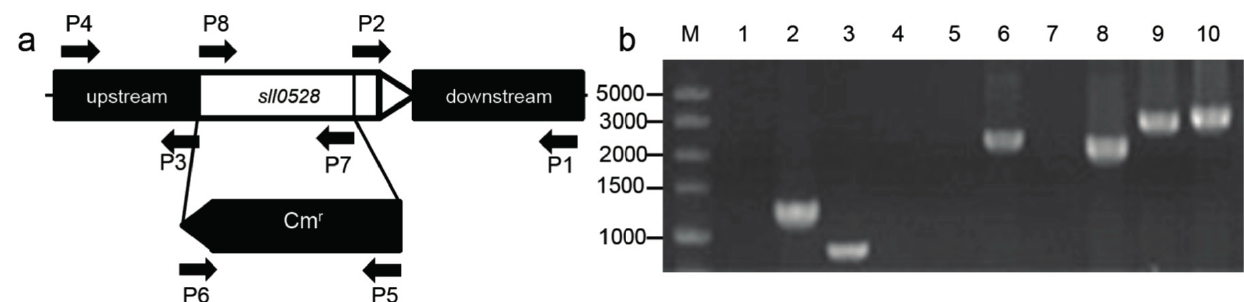
Figure 2. Construction of the sll0528 mutant. ( a ) The coding region of the sll0528 gene was replaced with a chloramphenicol resistance gene cassette (Cm r ) obtained from pACYC184. The arrows P1 to P8 indicated the primers used in PCR verification; ( b ) PCR verification of the sll0528 mutant. Template was genomic DNA from wild type (lanes 1, 3, 5, 7, 9) or sll0528 mutant (lanes 2, 4, 6, 8, 10). Primers used as indicated ( a ) were P5 + P6 (lanes 1, 2), P7 + P8 (lanes 3, 4), P1 + P6 (lanes 5, 6), P4 + P5 (lanes 7, 8) and P1 + P4 (lanes 9, 10). PCR products were sequenced to confirm their